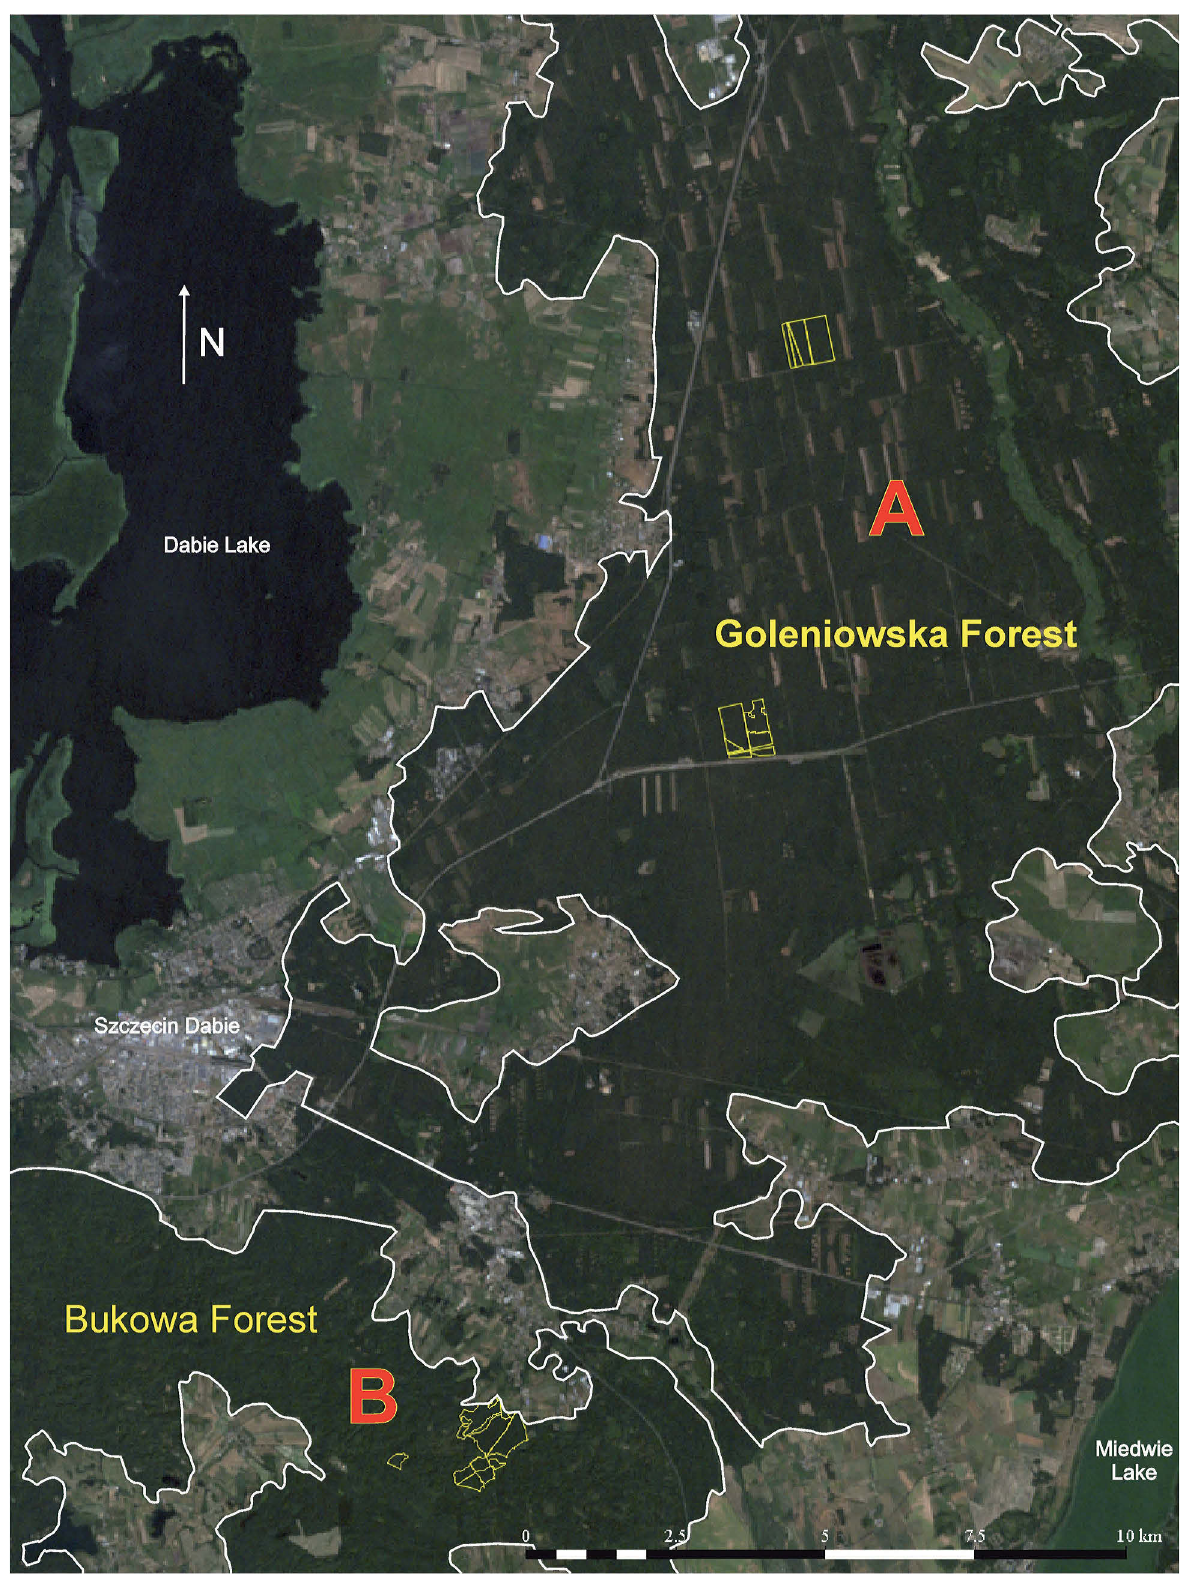
Fig. 2. Satellite image representing the Szczecin Lowland together with test area A (Goleniowska Forest with pine stands) and B (Bukowska Forest with beech